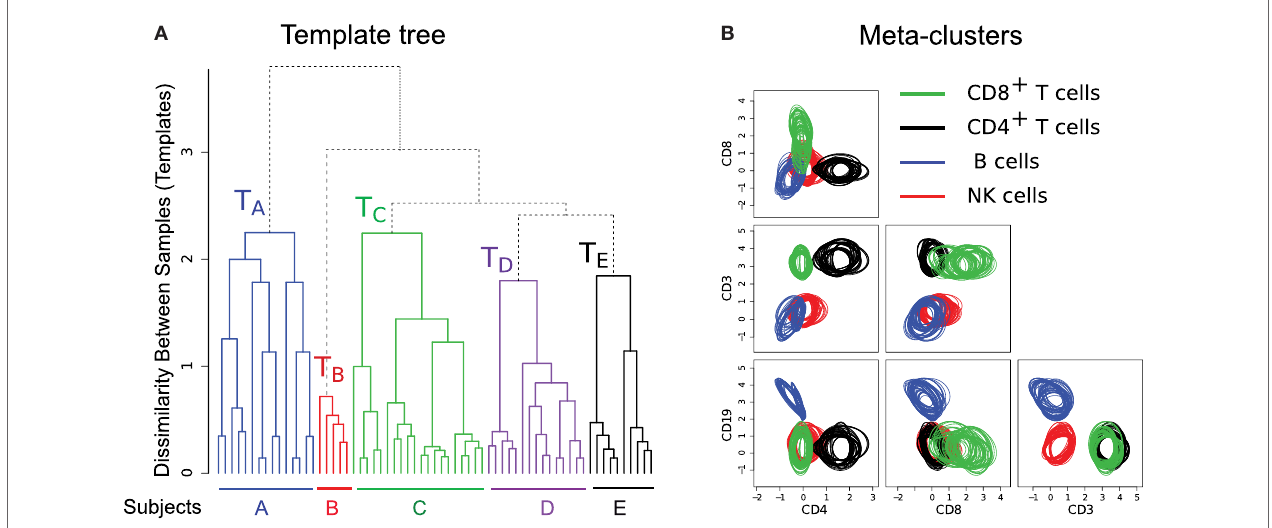
FigUre 8 | (a) The template tree created by HM&M algorithm from all samples of the HD dataset. Leaves of the dendrogram denote samples from five healthy individuals. An internal node represents a template, and the height of an internal node measures the dissimilarity between its left and right children. The sample- specific subtrees are drawn in different colors. (B) Bivariate projections of the combined template [the root of the tree in (a) ] are drawn in terms of its meta-clusters. Here, each meta-cluster is represented by a homogeneous collection of cell clusters that are drawn with the 95th quantile contour lines. Clusters participating in a meta-cluster are drawn in same